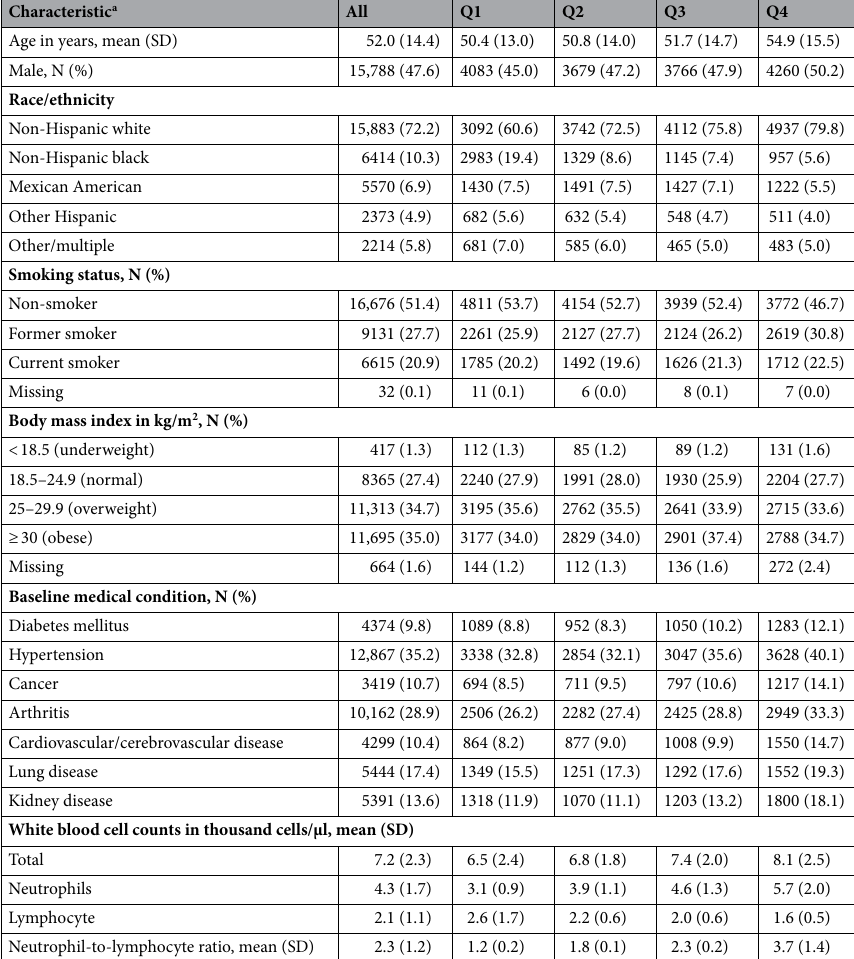
Table 1. Baseline characteristics of the study population, overall and according to neutrophil-to-lymphocyte ratio quartiles (NHANES, 1999–2014). SD standard deviation. a N corresponds to the unweighted sample size. Percentages, means, and standard deviations are weighted to reflect sample design, participation rates, and the inclusion of multiple NHANES surveys (see